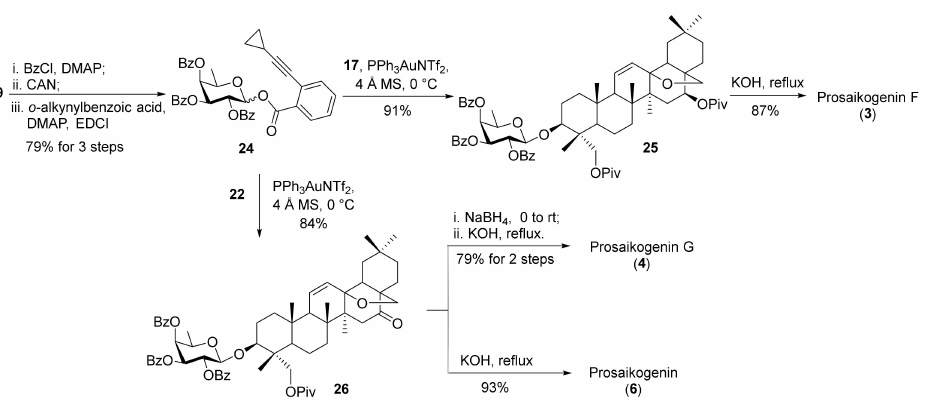
Scheme 7. Synthesis of prosaikosaponin F ( 3 ), G ( 4 ), and prosaikogenin ( 6